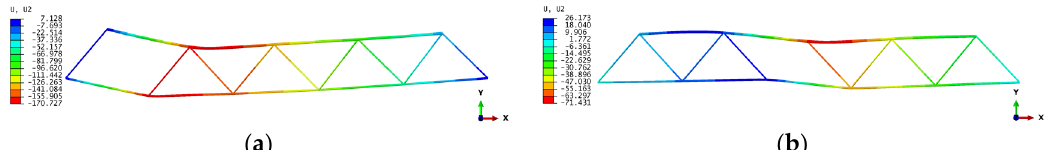
Figure 17. Structural deformation diagram under two working conditions: ( a ) W2 failure condition, ( b ) W5 failure condition.